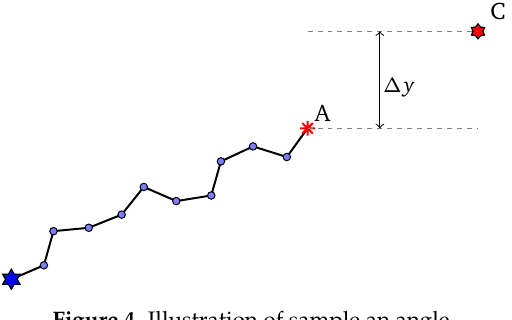
Figure 4. Illustration of sample an